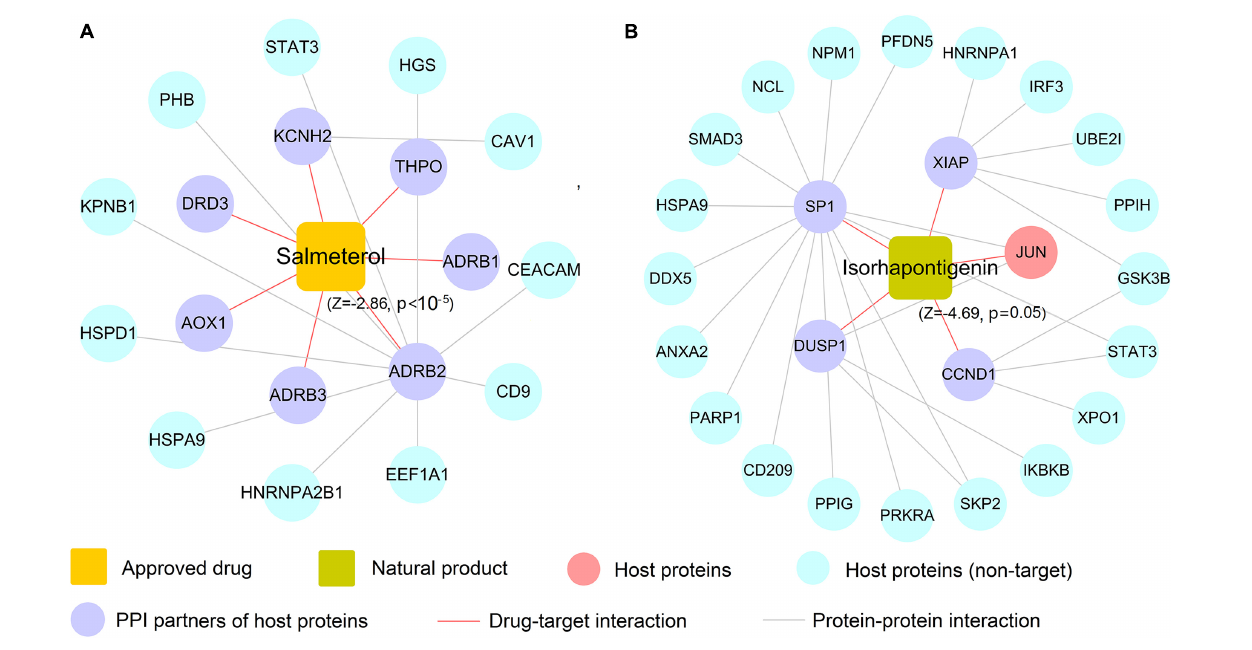
FIGURE 8 | The predicted associations of approved drug (salmeterol) and natural product (isorhapontigenin) on COVID-19. A drug–target network for salmeterol connecting 11 corresponding targets of host proteins and 7 protein–protein interaction (PPI) neighbors (A) . A drug–target network for isorhapontigenin interacting with one host protein and 25 PPI neighbors (B) . Drug–target networks were constructed based on the host gene set of Zhou et al.